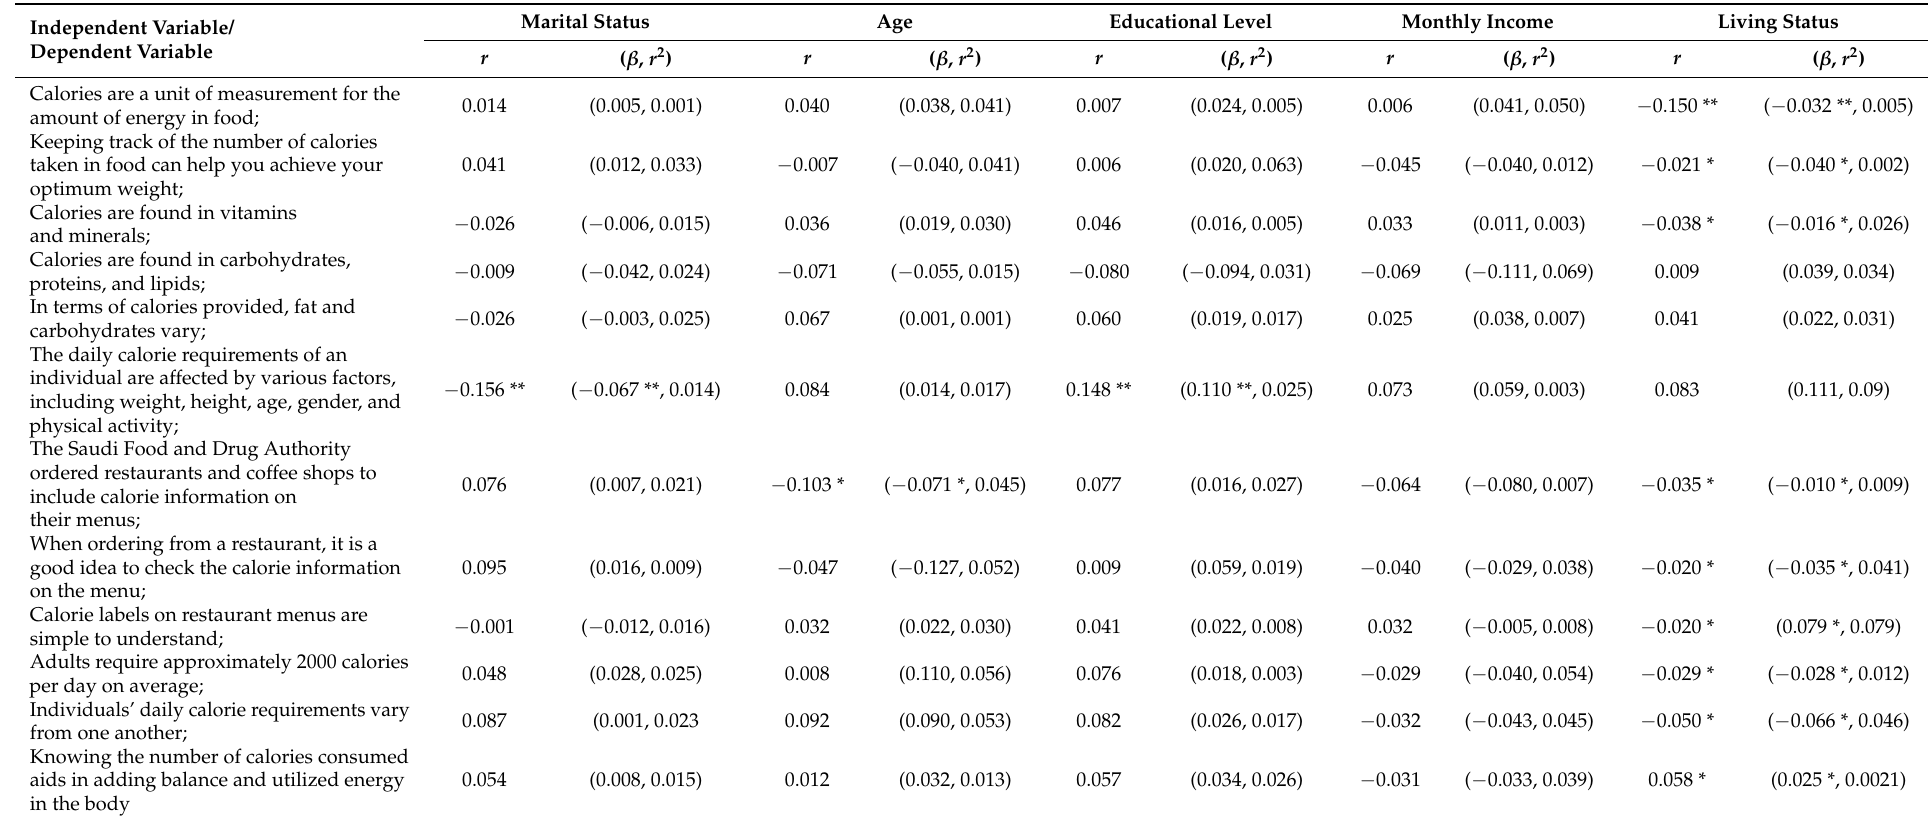
Table 4. Spearman correlation coefficients ( r ) and simple linear regression analysis ( β , r 2 ) between demographic characteristics and food label knowledge for males ( n =